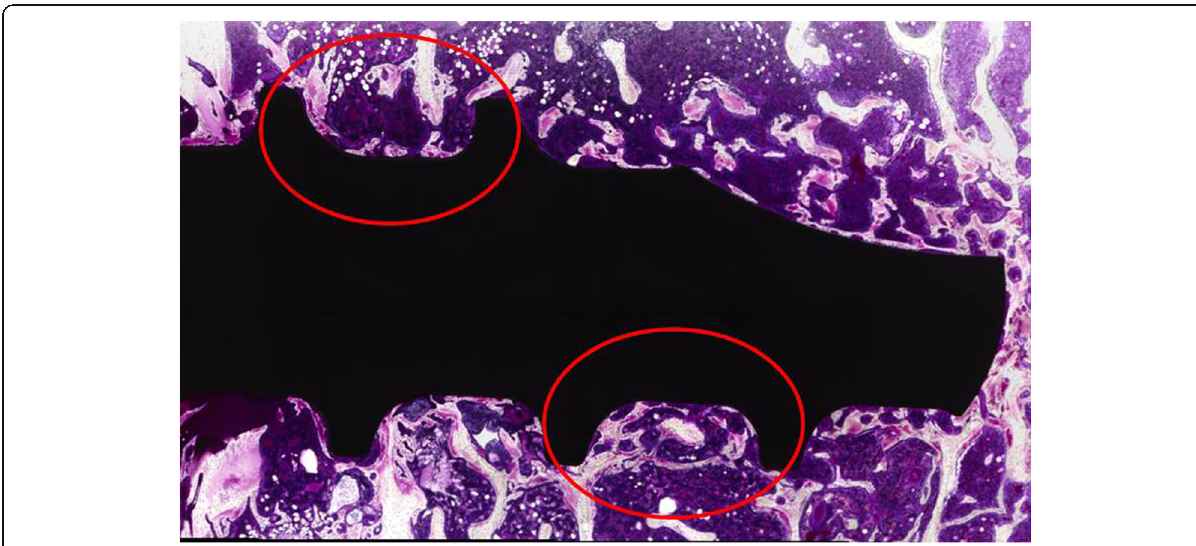
Fig. 5 The screw threads used for the histological evaluation. Samples were stained after grinding on the long axis of the screw. The two threads of a screw nearest to the tip were used for histological evaluation (red